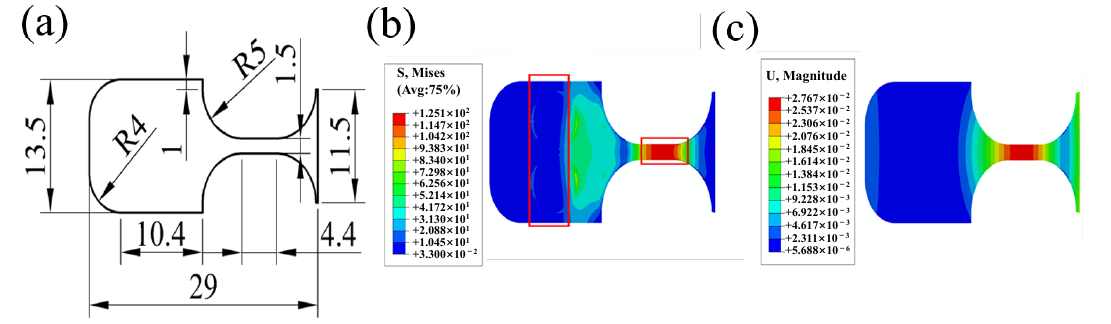
Figure 2. Specimen sketch and simulation result at the resonant frequency. ( a ) Dimensions of bending test sample; ( b ) Von-Mises stress field; ( c ) out-plan displacement field.